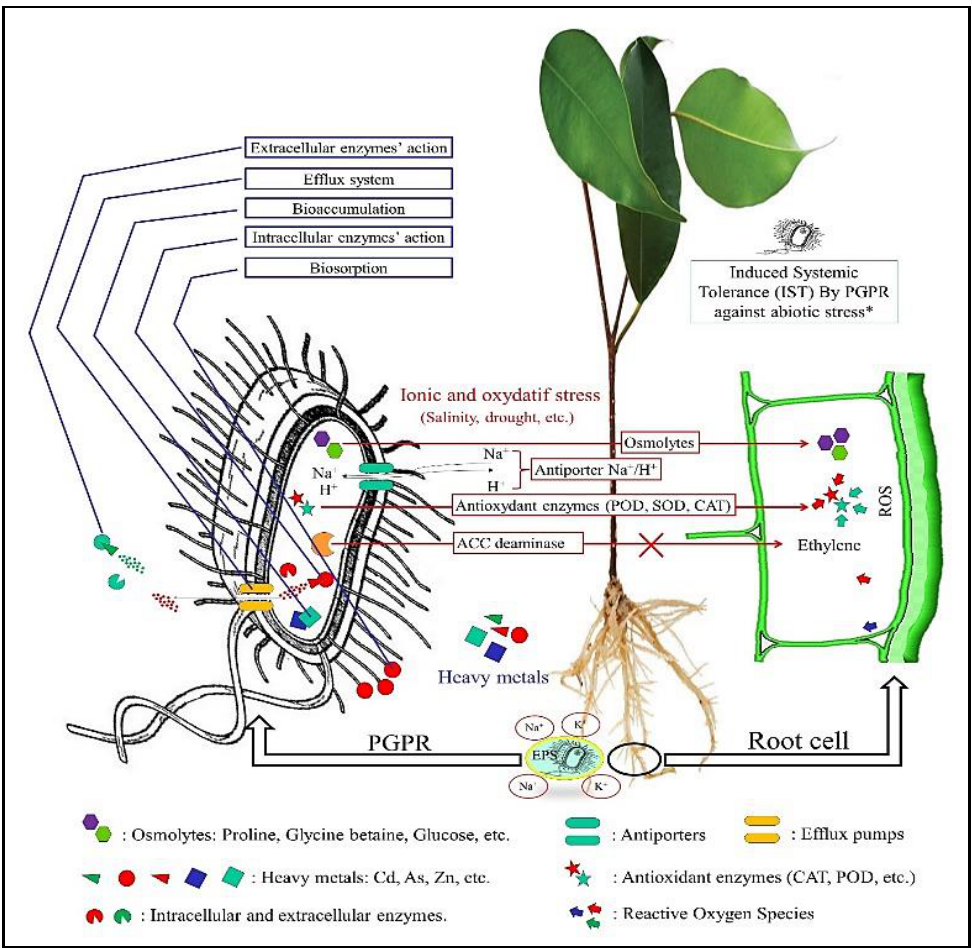
Figure 1. Principal mechanisms of bacterial bioremediation and plant growth regulation under abiotic stresses. * (IST): see Section 3.